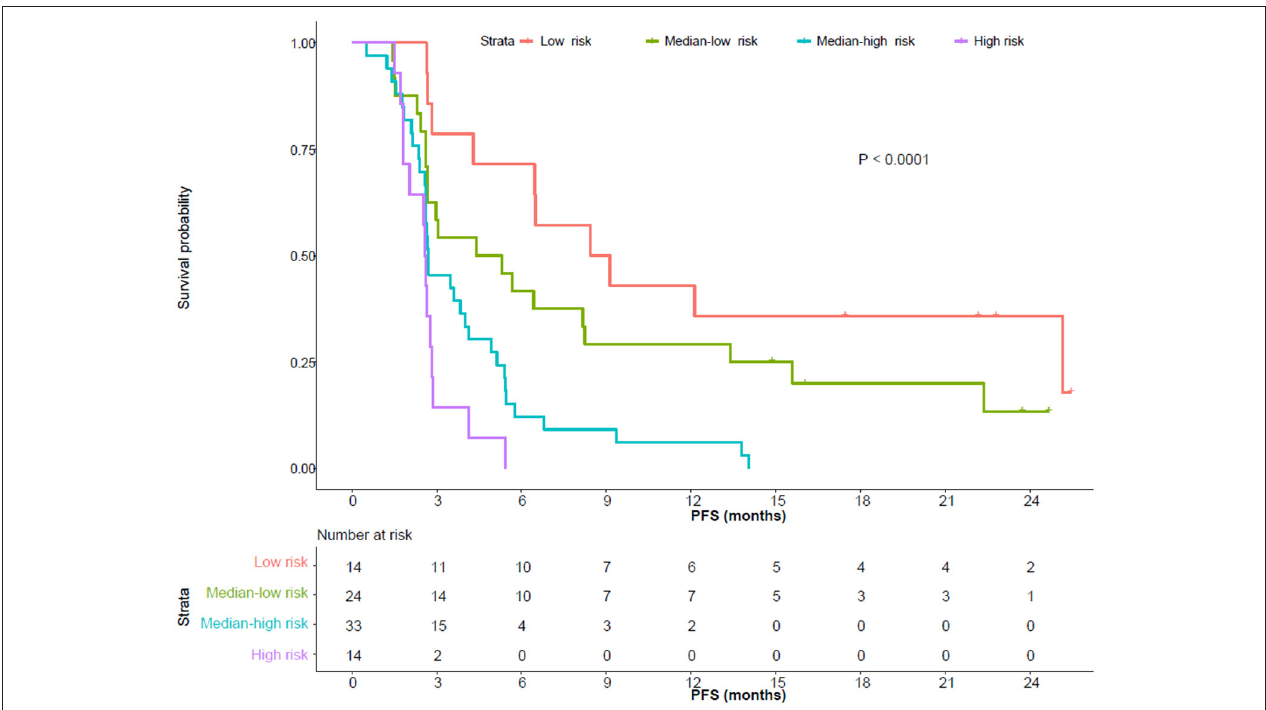
FIGURE 1 | Progression-free survival (PFS) of patients with different risks. The median PFS of patients with low, median-low, median-high, and high risks was 8.8 (95% CI, 6.5-not reached), 4.9 (95% CI, 2.7–13.4), 2.7 (95% CI, 2.6–4.9) and 2.6 (95% CI, 2.0–4.1) months, respectively.